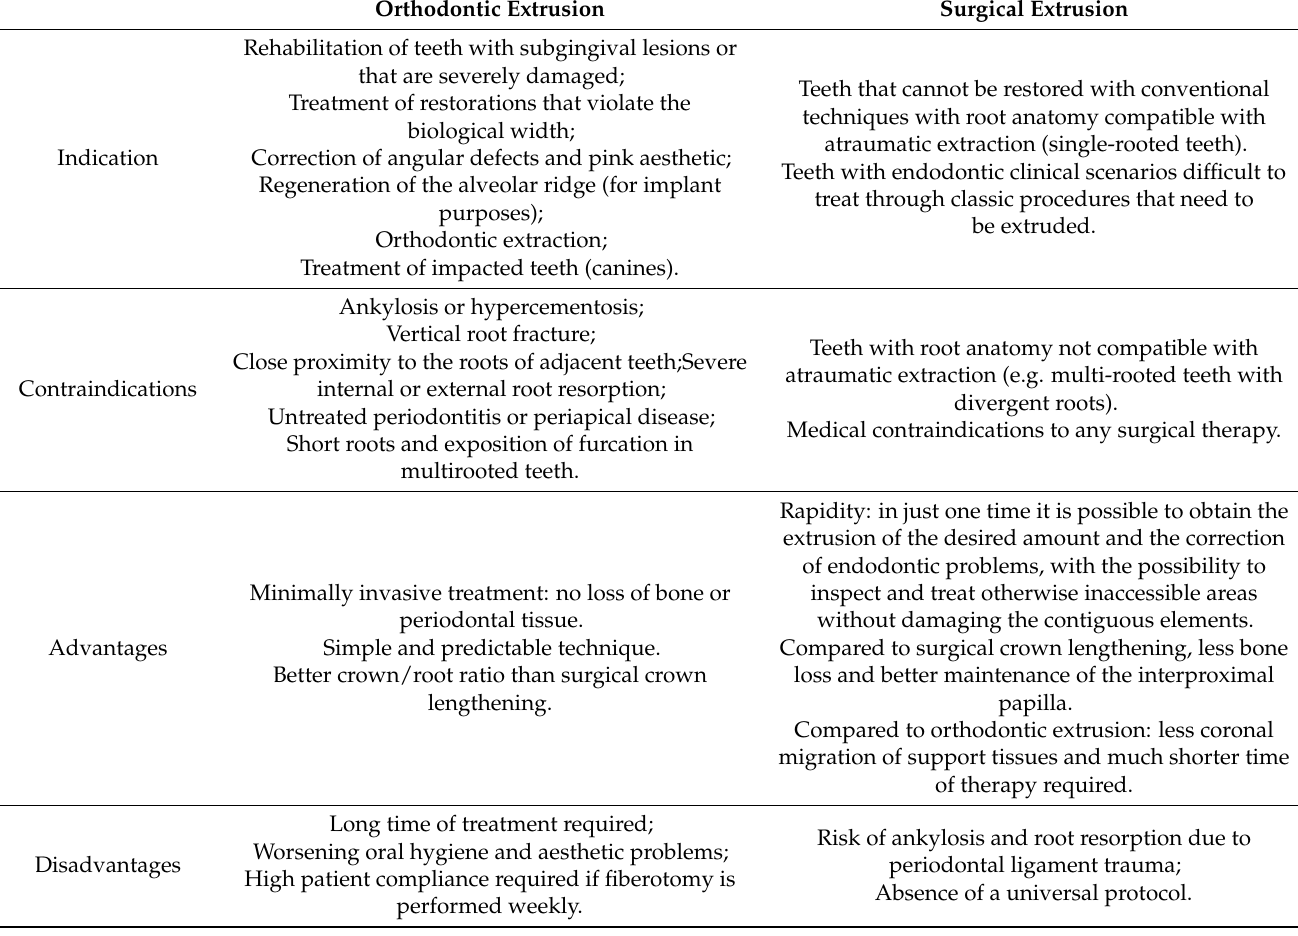
Table 1. Indications, contraindications, advantages and disadvantages of both orthodontic extrusion and surgical extrusion. Orthodontic Extrusion Surgical